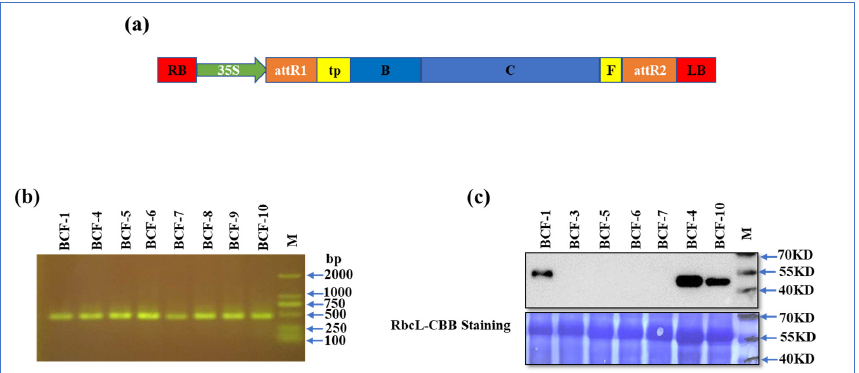
Figure 1. Vector construction and identification of transgenic plants expressing BCF. ( a ) Schematic presentation of the domain structures of the transgenic plants expressing BCF : The B and C domains of CAO , the predicted transit peptide ( TP ) sequence, and FLAG tag. ( b ) The 35S promoter and BCF inserted into the genome of the tomato plants were confirmed by PCR analysis, a target fragment of 477 bp. ( c ) The identification of the expression of BCF protein in positive transgenic plants by Western blotting. Anti-FLAG antibody was used as the primary antibody, and HRP goat anti-mouse IgG was used as the secondary antibody.